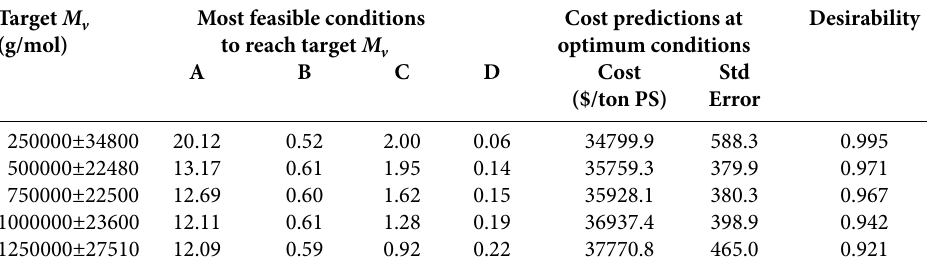
Table 6. Multi objective optimization